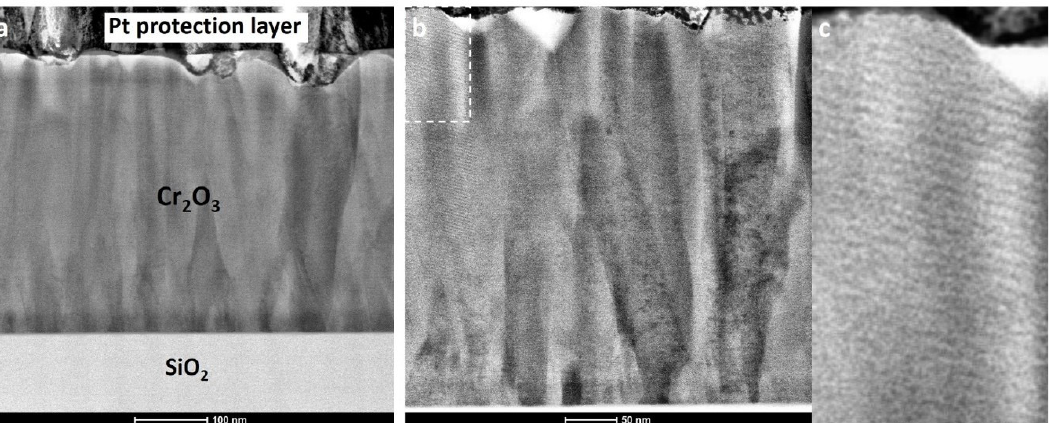
Figure 10. Bright-field STEM images of Cr 2 O 3 film on SiO 2 glass substrate deposited at 420 °C with 4300 ALD cycles. The scales are 100 nm and 50 nm for the ( a ) and ( b ) image, respectively. ( c ) is an enlarged cut-out of top left corner of the image ( b ).